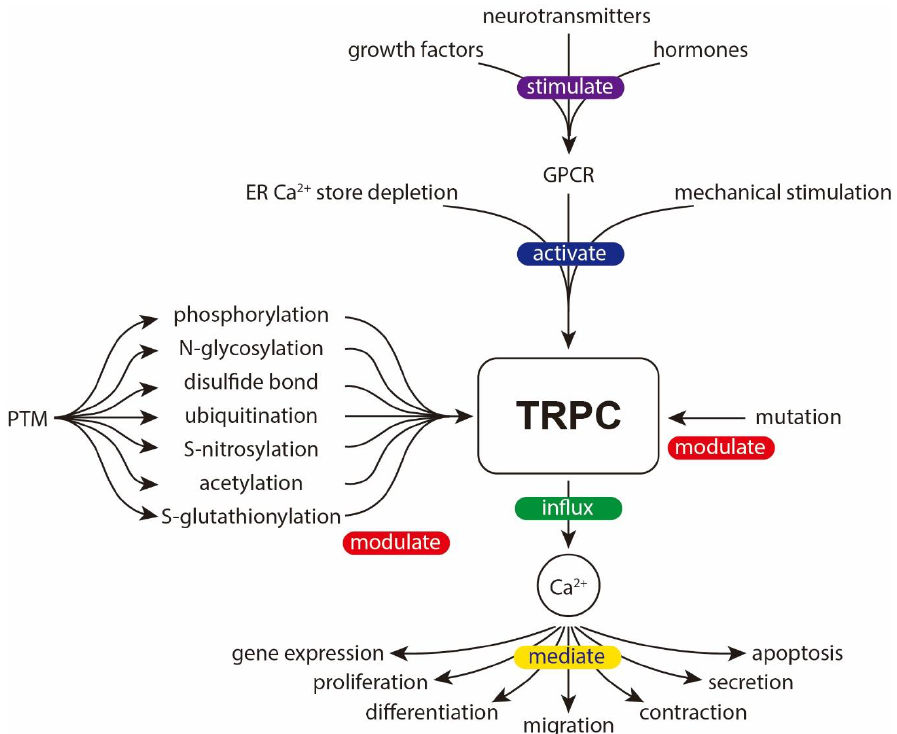
Figure 8. Overview of the signal transduction through TRPC channels. TRPC can be activated by endoplasmic reticulum (ER) Ca 2+ store depletion, GPCRs (sensing extracellular stimuli such as growth endoplasmic reticulum (ER) Ca 2 + store depletion, GPCRs (sensing extracellular stimuli such as